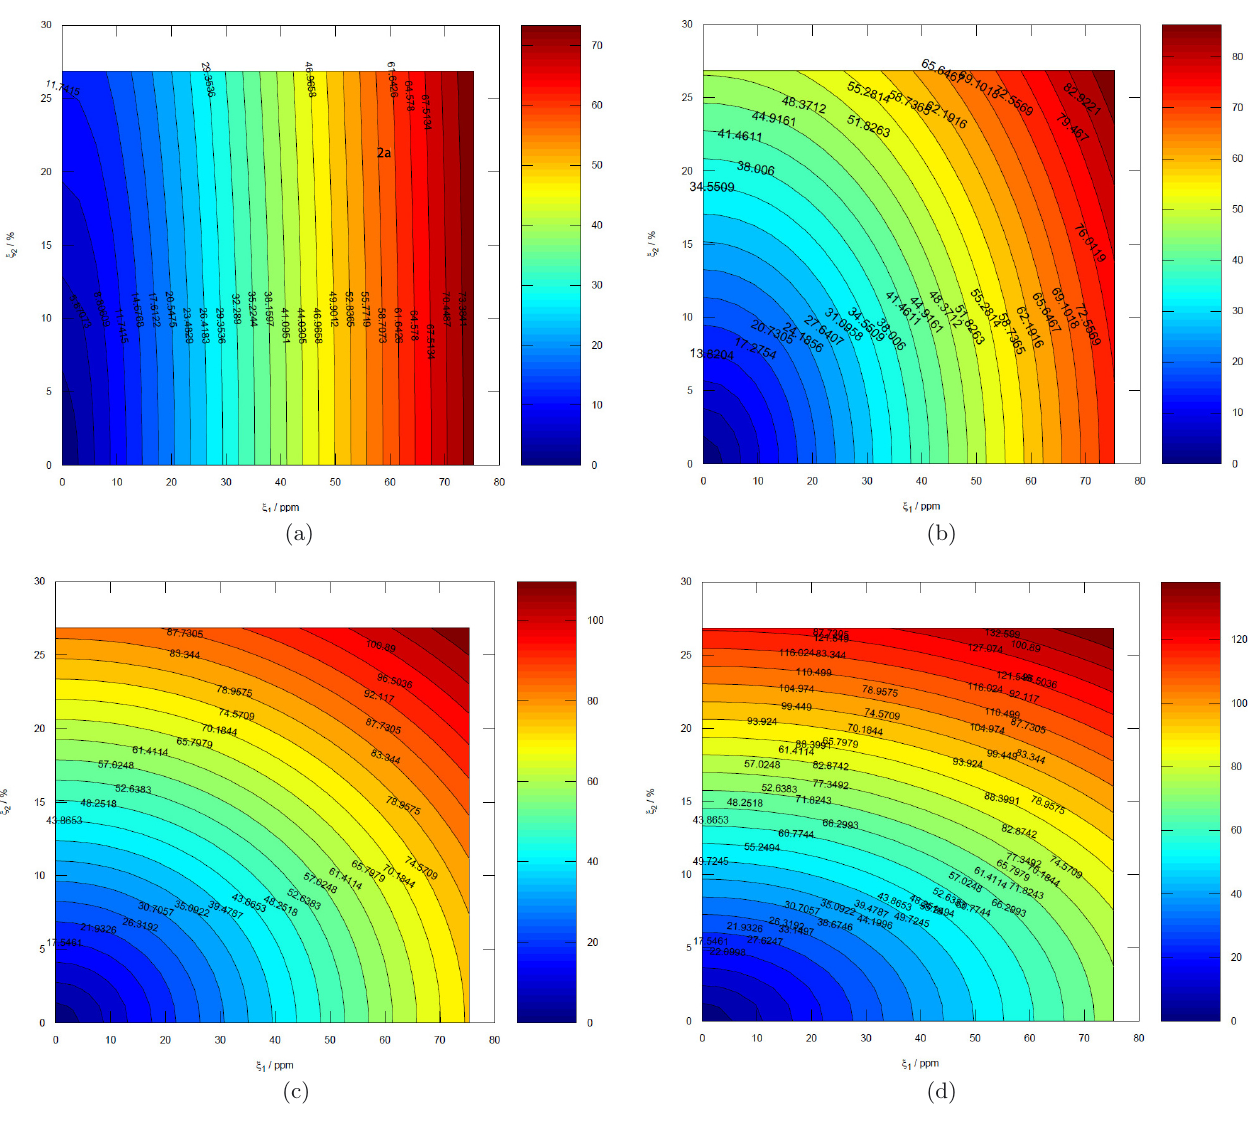
Fig. 3. (Color online) Qualitative uncertainty analysis for relative standard uncertainty in zero-pressure area ξ 1 = u ( A 0 ) /A 0 and relative standard uncertainty in distortion coefficient ξ 2 = u ( λ ) /λ contributions to the relative standard uncertainty in applied pressure η = u ( P ) /P expressed in ppm. The range of ξ i ( i = 1 , 2) is chosen as 0 ≤ ξ i ≤ 2 u ( a i ) /a i where a = { A 0 , λ } to encompass the full possible spectrum of potential range of values within the expanded uncertainty using an approximate coverage of k = 2 for a confidence interval at 95% significance. The expected calculated uncertainty values are u ( A 0 ) /A 0 = 37 . 7 ppm η ( ξ 1 , ξ 2 ) = 0 correctly converges as expected and u ( λ ) /λ = 13 . 4% for the illustrative example and its seen that lim ξ 1 → 0 ,ξ 2 → 0 with 0 ≤ η ≤ 120 ppm over the range of applied pressures 50 MPa ≤ P ≤ 500 MPa. (a) Results for 50 MPa. (b) Results for 200 MPa. (c) Results for 350 MPa. (d) Results for 500